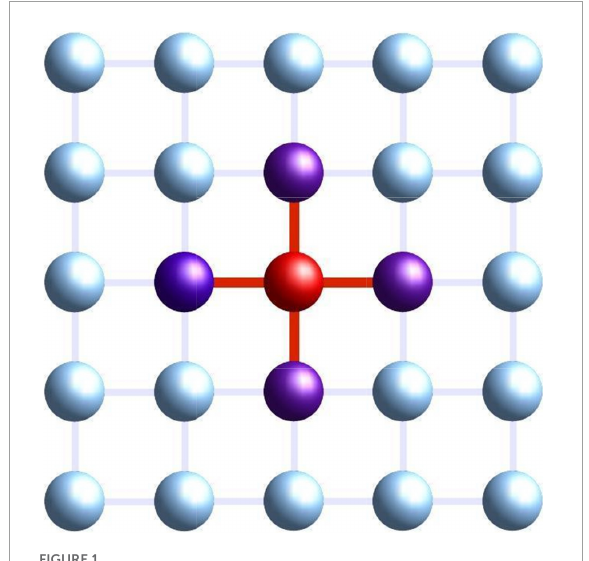
FIGURE1 Geometric virtual disposition of students. For instance, the red one is connected with (can see or copy from) four neighbors. Used with permission from Kampal Data